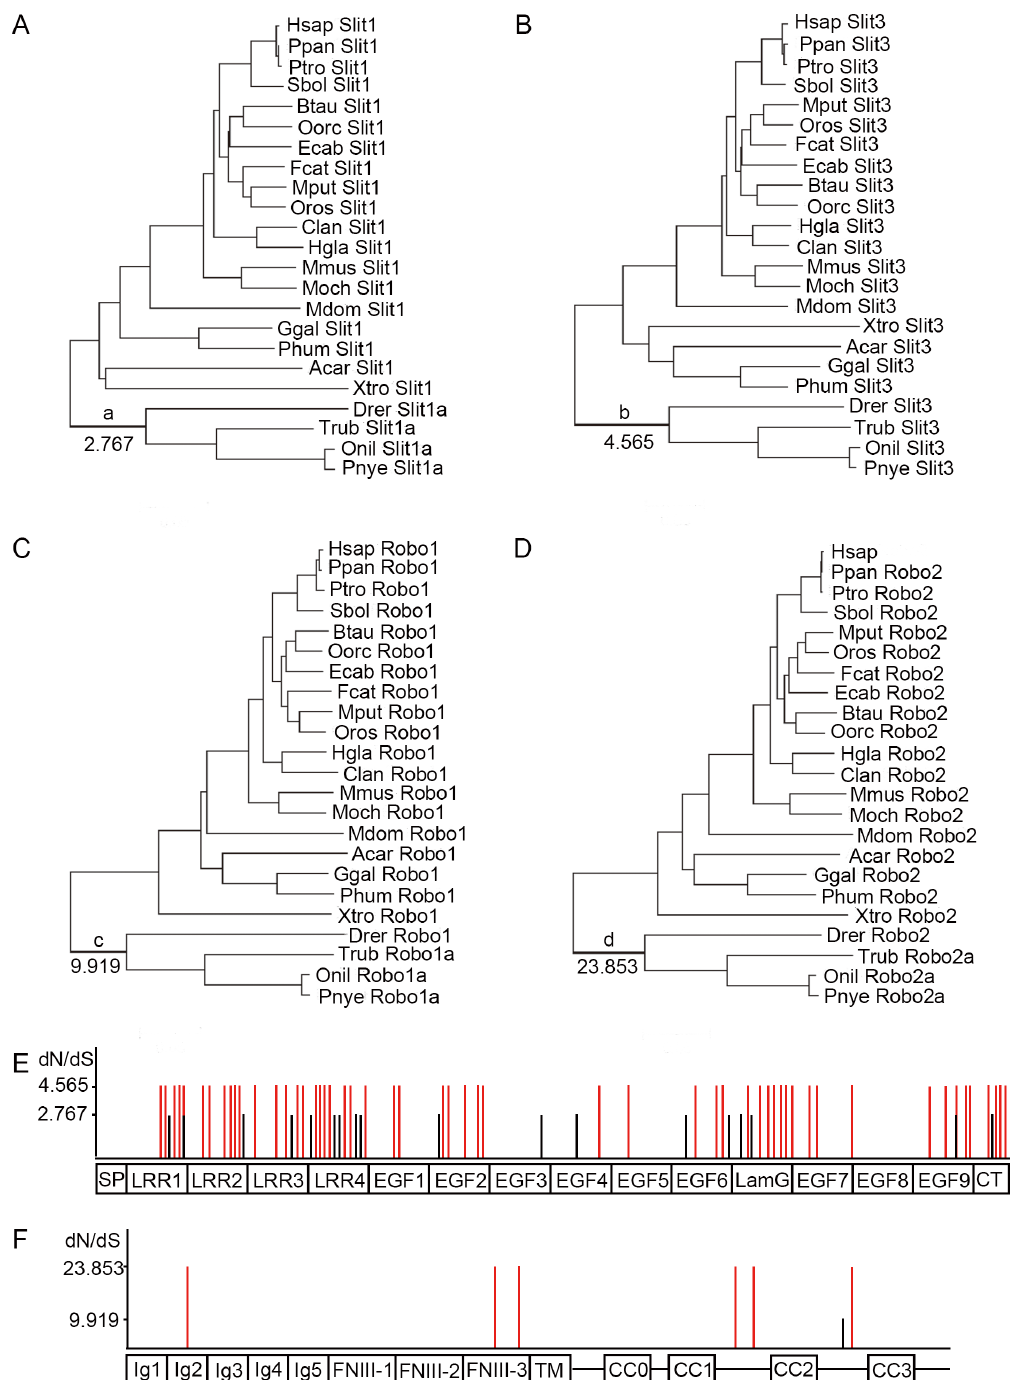
Figure 3. Positive selection of slit1 , slit3 , robo1 and robo2 in vertebrates. (A–D) Phylogenetic trees of slit1 (A), slit3 (B), robo1 (C) and robo2 (D). All of these genes under positive selection were detected along the teleost lineages. The v values of sites under positive selection were marked along the teleost lineage. a, b, c and d indicated the teleost lineage. Taxa names are abbreviated with the first letter of the genus and the first three letters of the species. (E) Mapping positively selected sites identified in slit1 (black bars) and slit3 (red bars) to domain structures of Slit. (F) Mapping positively selected sites identified in robo1 (black bars) and robo2 (red bars) to domain structures of Robo.